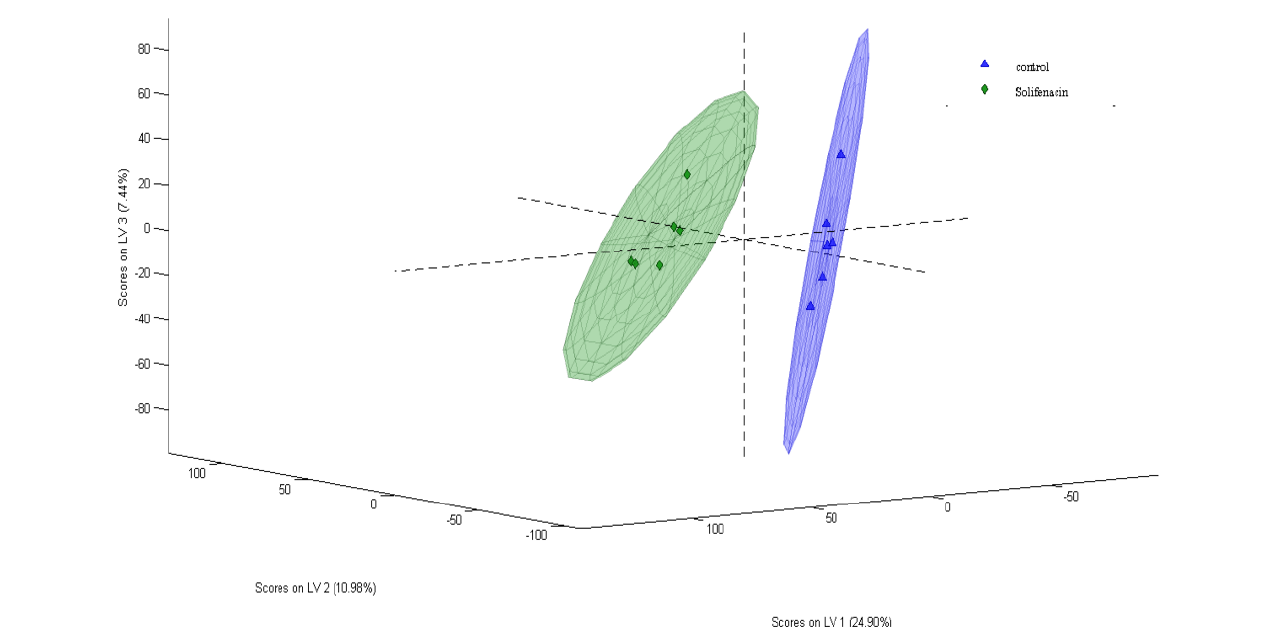
FIGURE 2 - OPLS-DA Score plot for drug-administered group (green) vs control group